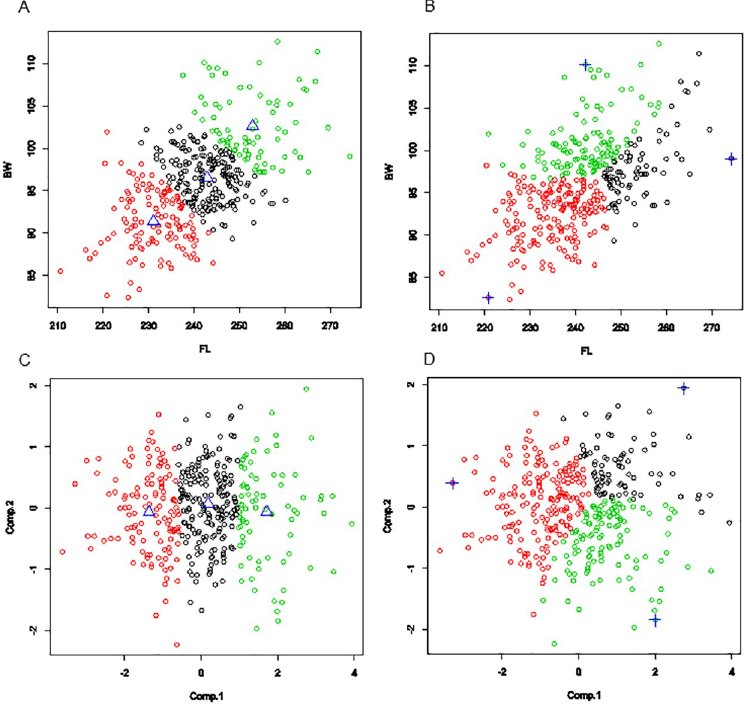
Fig 1. Toy example. (A) Plot of the k -means cluster assignments. The blue triangles represent the centroids of each cluster. (B) ADA assignments by the maximum alpha (see Section 2), i.e. assigned to the archetypoid that best explains the corresponding observation. The blue crosses identify the archetypoids. (C) PC scores with cluster assignments. Projected centroids are represented by blue triangles. (D) PC scores with the ADA assignments. Projected archetypoids are represented by blue